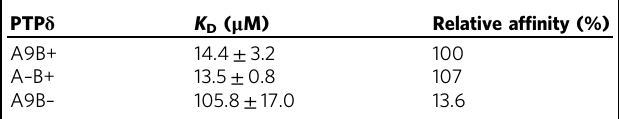
Table 2 Binding af fi nities between PTP δ splicing variants (Ig1 – Fn1) and SALM5 (LRR – Ig)